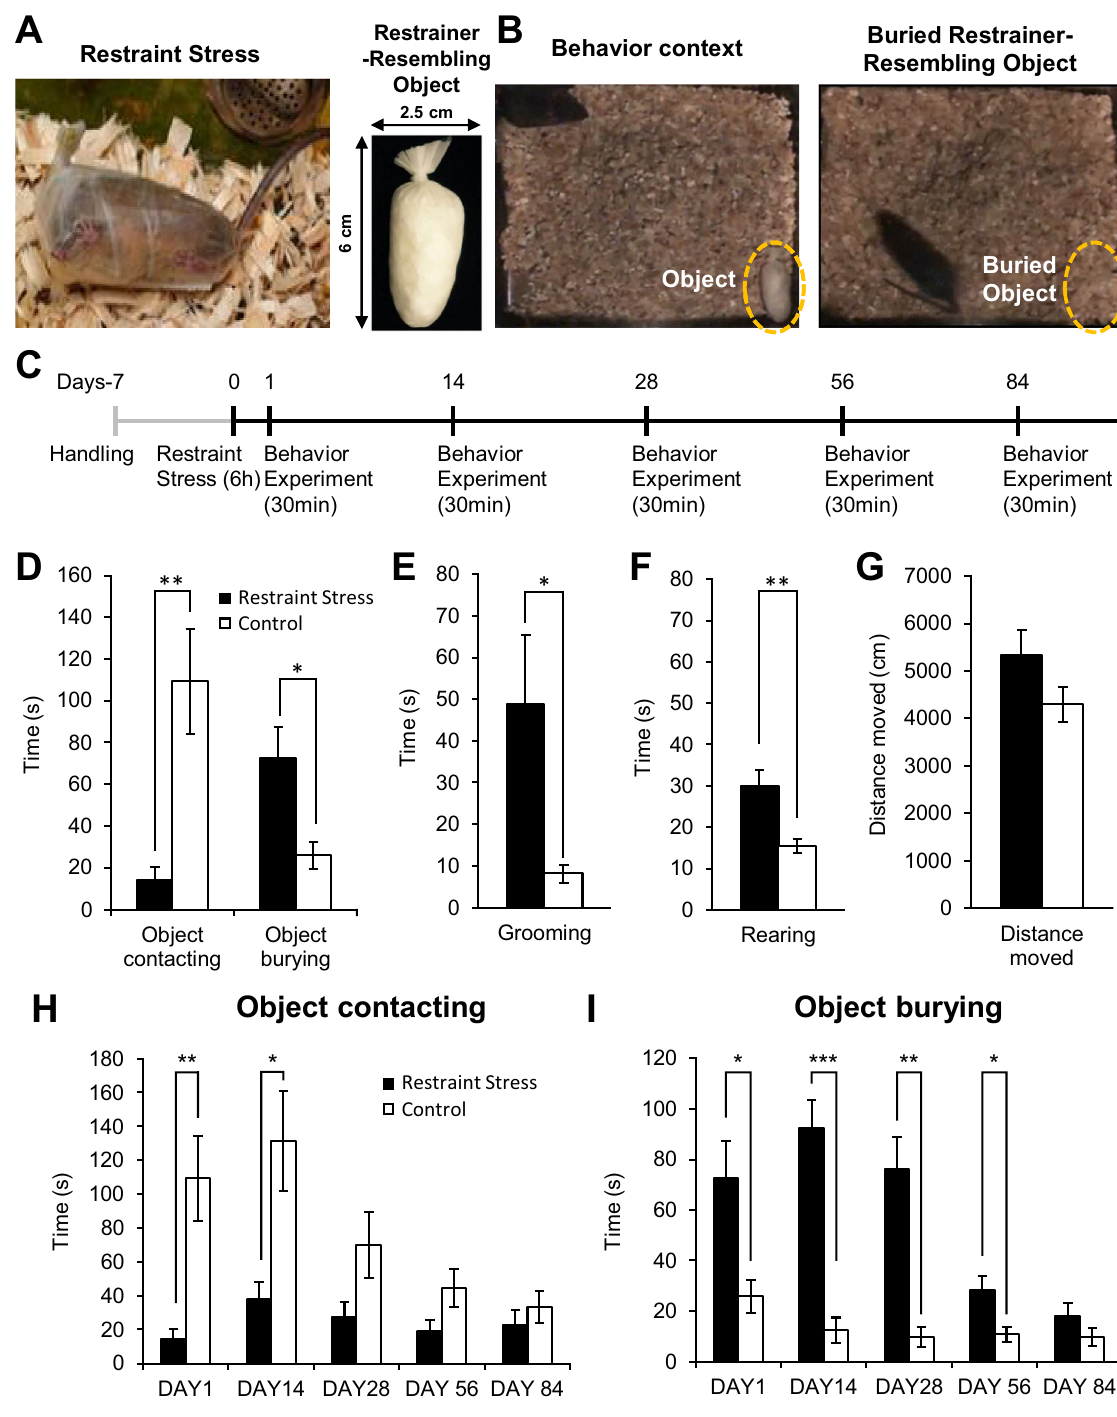
Figure 1. Fear and anxiety-like behaviors induced by acute restraint stress. ( A ) Images of a mouse experiencing restraint stress (left) and a restrainer-resembling object (right). ( B ) Image of an experimental setting (left) and an exemplarily image of a restrainer-resembling object buried by a stressed mouse (right). ( C ) The timeline of experiments. ( D ) Contacting and burying of a restrainer-resembling object in stressed and control mice in the first experiment (day 1). Contacting behavior includes biting, carrying, touching, and manipulation of a restrainer-resembling object. ( E ) Cumulative duration of grooming behavior during in the first experiment (day 1) between groups. ( F ) Rearing behavior (also known as the attempt of escape behavior) of mice in the first experiment (day 1). ( G ) Total distance moved of mice during in the first experiment (day 1). ( H ) Changes in contacting behavior of the restrainer-resembling object over time between stress and control groups. ( I ) Changes in restrainer-resembling object burying behavior over time between stress and control groups. ( D–I ) Control (n = 8), Restraint stress (n = 8). All data are presented as mean ± standard error of mean (SEM). Student’s t-test was used to compare means between the stress and the control group. *p < 0.05, **p < 0.01, ***p <